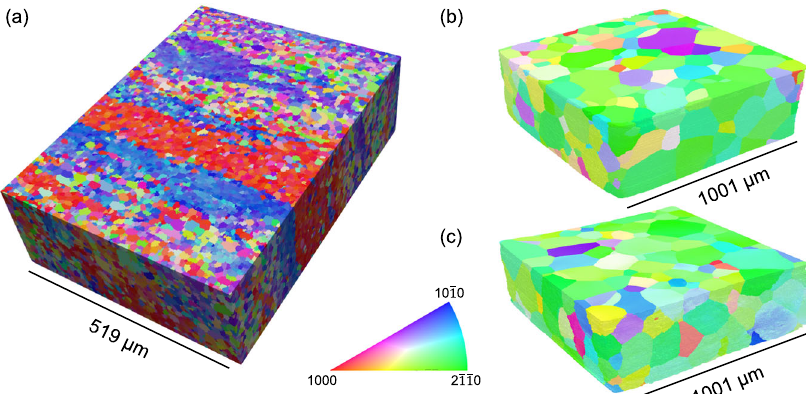
Fig. 6 Rendering of 3D EBSD datasets Investigated. Shown in IPF coloring of the titanium alloys, a Ti-6Al-4V and b Ti-7Al mechanically loaded in tension to 1% strain and c 3%, used for network training, testing and validation. Dataset details are available elsewhere 31,32